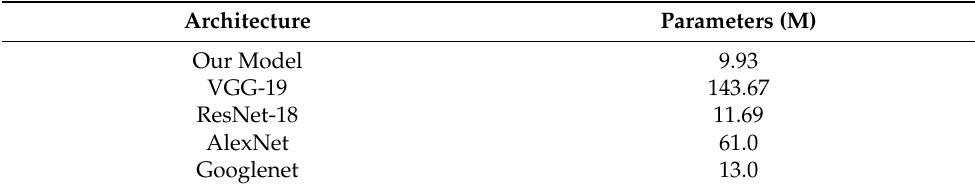
Table 4. Reference Protocol (RP)